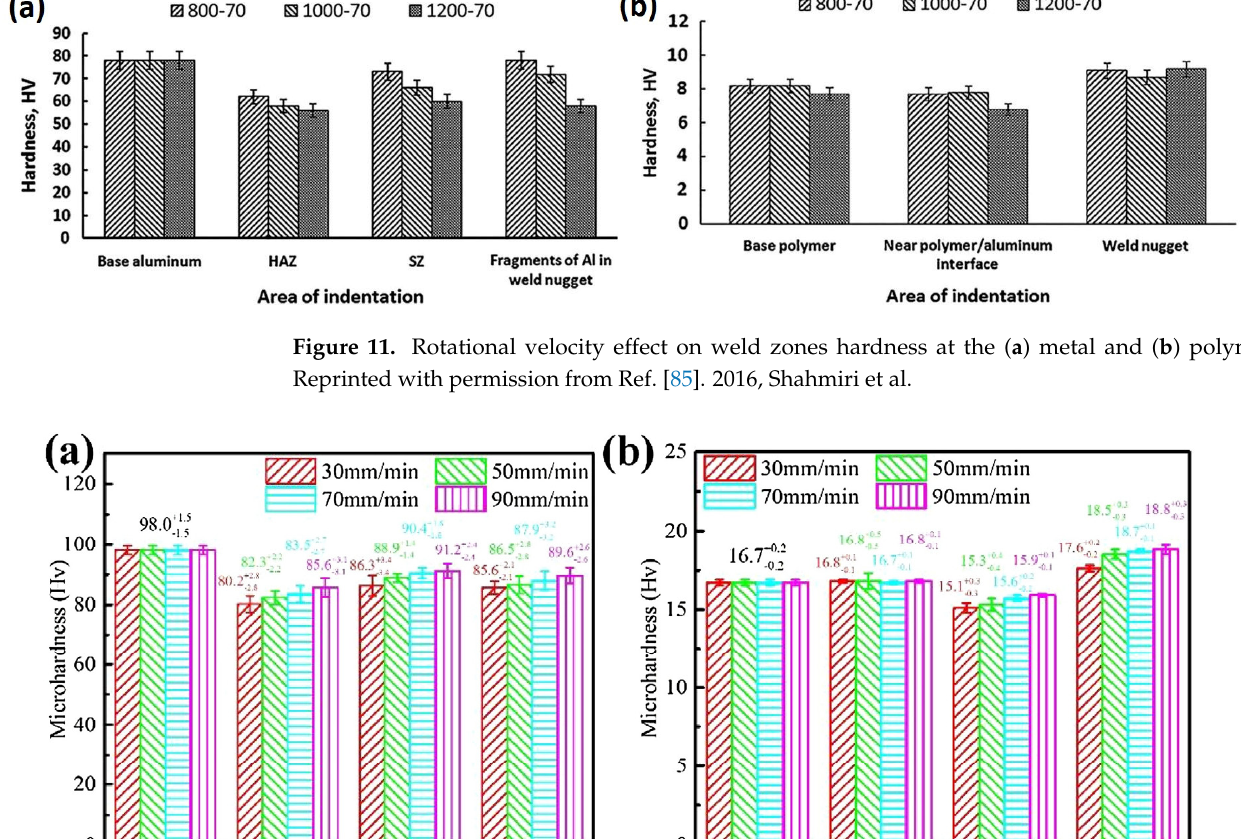
Figure 12. Traverse speed effect on weld zones hardness at the ( a ) metal and ( b ) polymer. Reprinted with permission from Ref. [82]. 2018, Y. Huang et al.